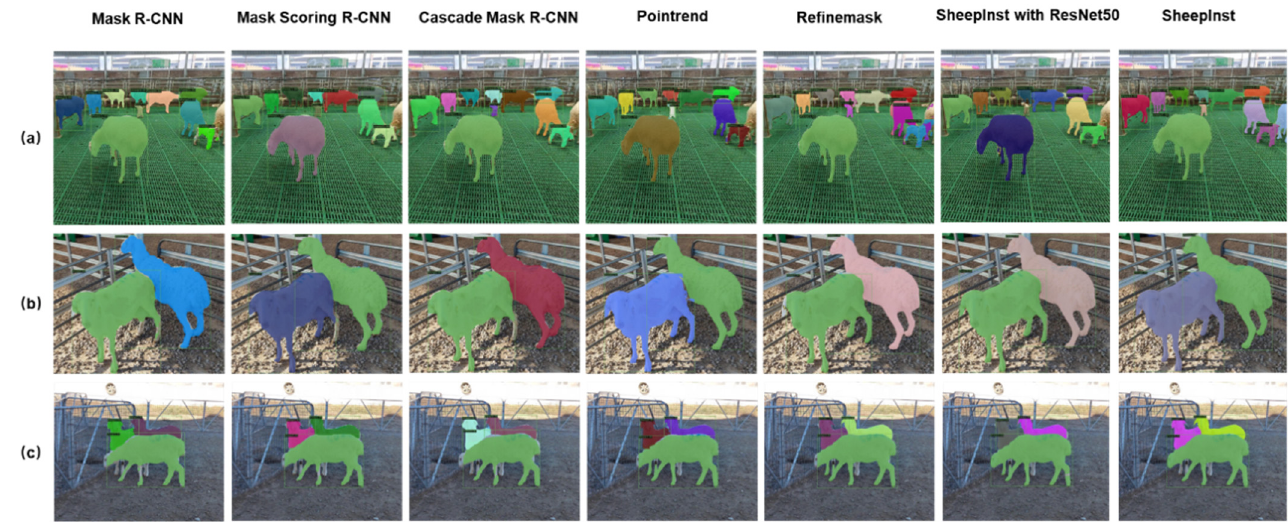
Figure 2. Example result from our work and other methods on test set. ( a ) represents the results of multiple sheep indoors. ( b ) represents the results of close distance outdoors ( c ) represents the results of high overlap outdoors. Except for the last column, the backbone of all the methods is ResNet-50.